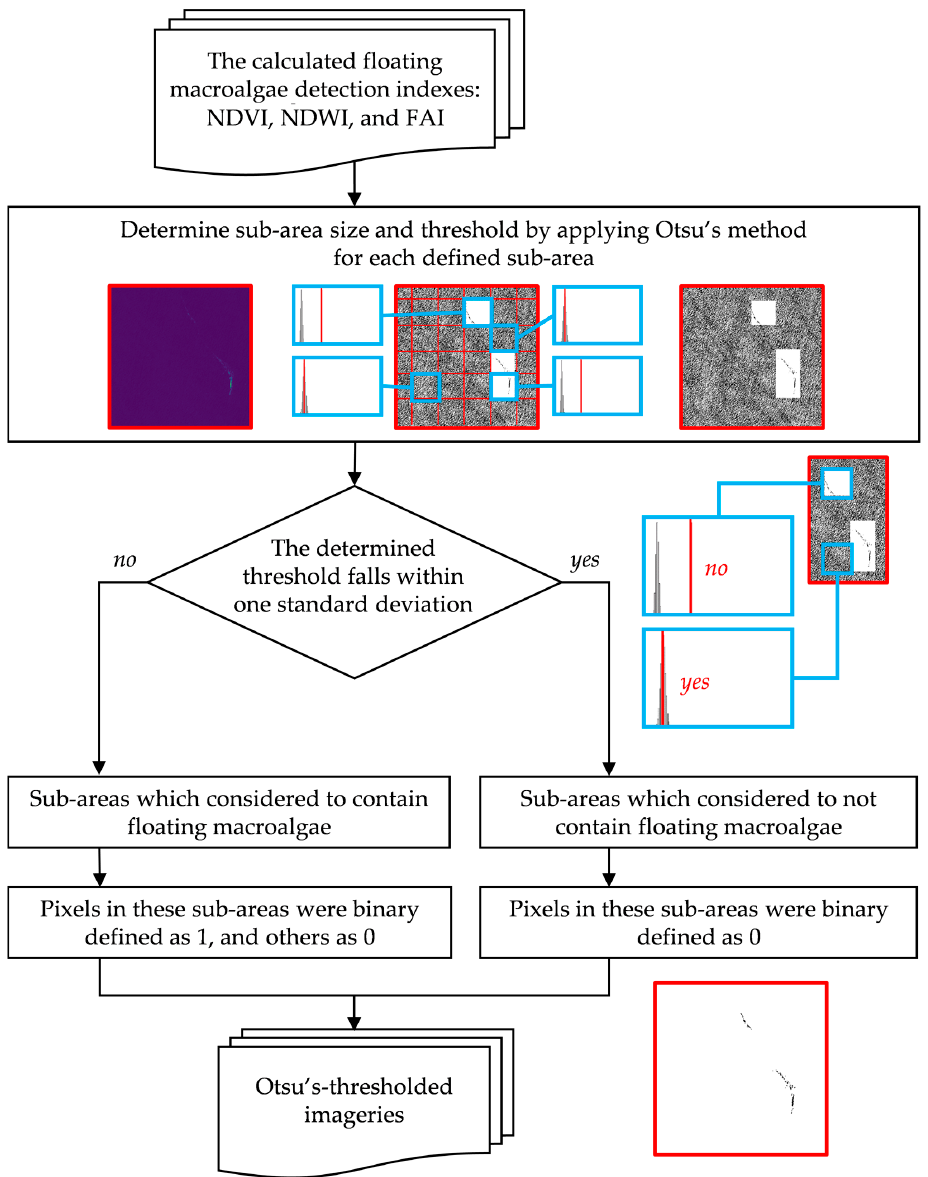
Figure 6. Floating macroalgae detection via image splitting and Otsu’s method [11,12]. The details of these methods are found in the main text.